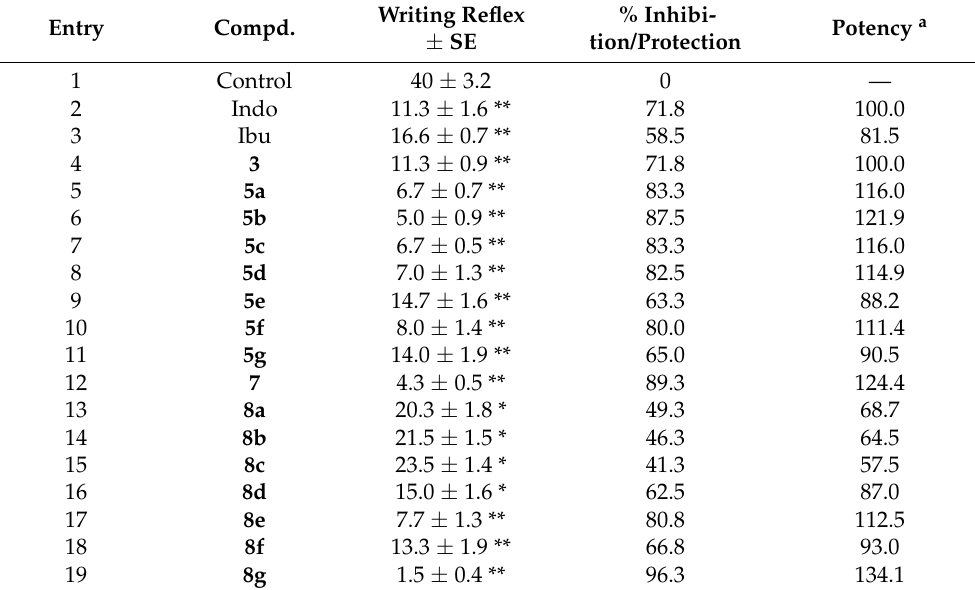
Figure 3. % Inhibition of edema thickness by the tested compounds. Table 2. Peripheral analgesic properties of the synthesized